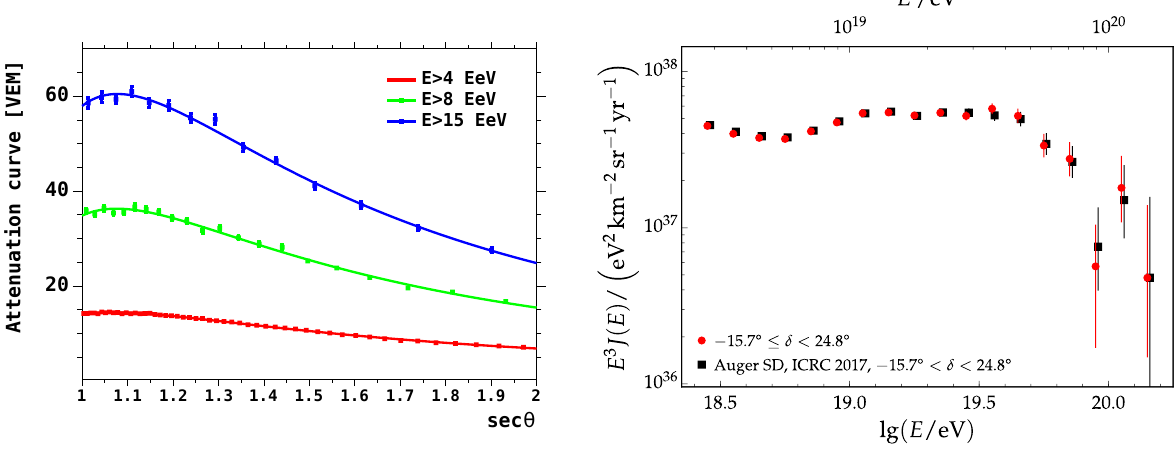
Figure 11. Left: Attenuation curves using the constant intensity cut method for the Auger SD made for multiple energy thresholds. Right: Comparison of the Auger SD spectra calculated using the standard Auger method (black squares) and the new, energy-dependent constant intensity cut method (red